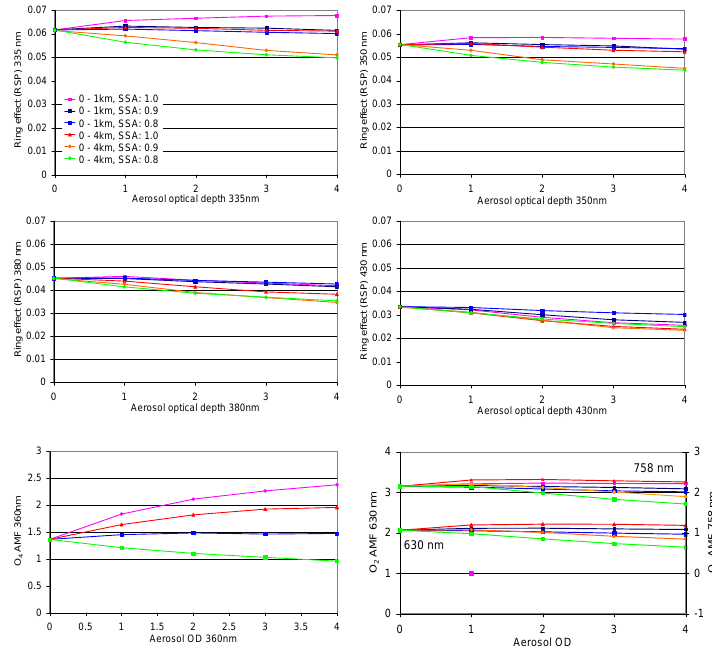
Fig. A4 Dependence of the Ring effect and the O 2 and O 4 absorptions on the AOD. The calculations are performed for SZA of 30° and a viewing angle of -90° (nadir geometry). The aerosol asymmetry parameter was assumed to be 0.68. For 758 nm the surface albedo was set to 20%, for 630 nm to 10%, and for all other wavelengths to 5%.